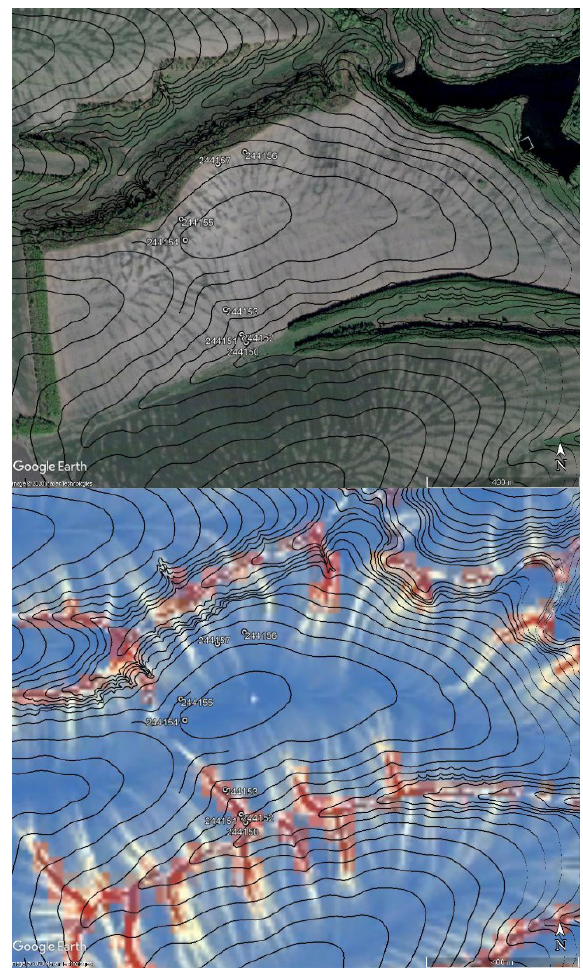
Figure 2. Fragment of the catchment area map (lower image) compared to the fragment of satellite image of the study area (upper image); black curves – relief contours; dark red stripes in the catchment area map indicate ancient ravine thalwegs); the data are visualized in Google